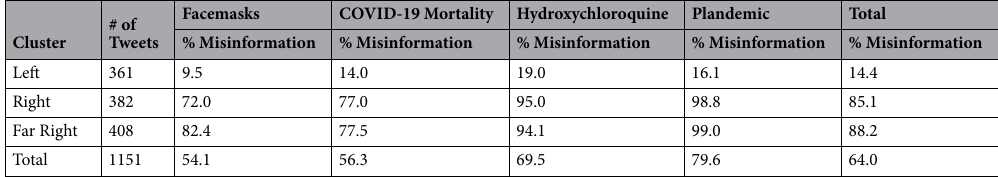
Table 1. Frequency of COVID-19 misinformation within Left, Right, and Far Right clusters by topic. For each topic (facemasks, COVID-19 mortality, hydroxychloroquine, Plandemic), the listed percentage denotes the proportion of the corresponding cluster’s tweets on that topic containing misinformation. A small number of tweets contained misinformation regarding multiple topics.